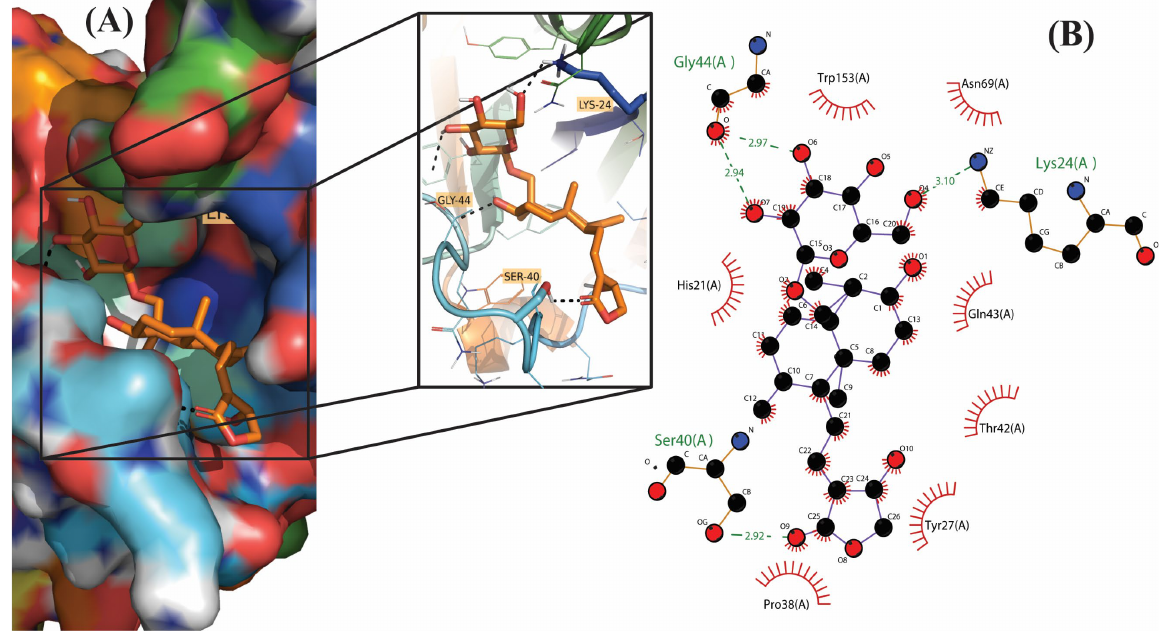
Figure 3. Molecular docking results of Andrographiside into the catalytic domain of diphtheria toxin. ( A ) Three-dimensional binding mode of Andrographiside in the protein active site. ( B ) Two-dimensional interaction showing amino acid residues involved in hydrogen and hydrophobic interactions.